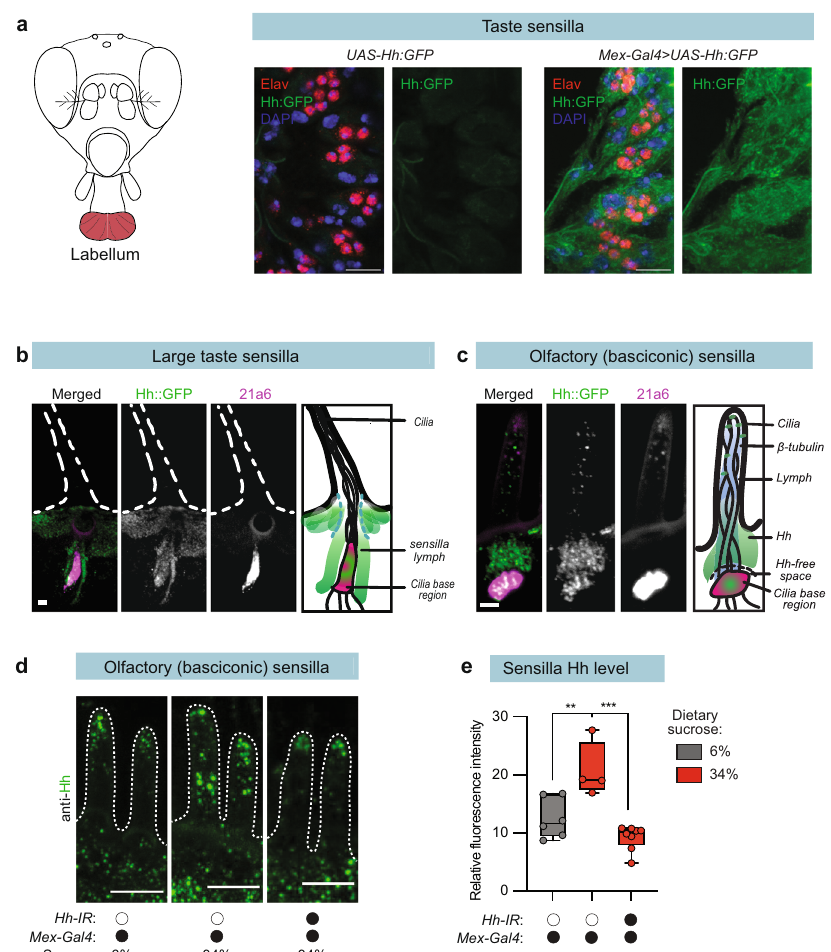
Fig. 5 | Gut-derived Hh is transported to the antenna and labellum. a Visualization of gut-expressed Hh:GFP ( Mex-Gal4 > Hh:GFP ) in the labellum. Anti- Elav staining is in red, DAPI in blue. b Taste sensilla in Mex-Gal4 > Hh:GFP fl ies, Hh:GFP (GFP, green) and cilia base (21A6, magenta). c Olfactory sensilla in Mex- Gal4 > Hh:GFP fl ies, Hh:GFP (GFP, green), and cilia base (21A6, magenta). d Visualization of endogenous Hh localization in basiconic sensilla, Hh (green).